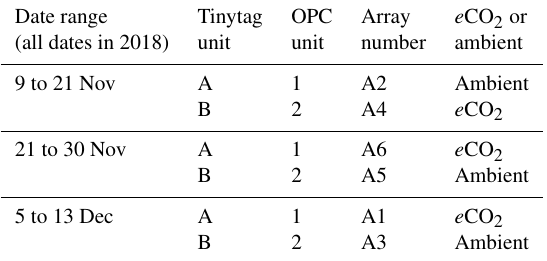
Table 1. Table listing the dates and locations of equipment installa- tion across the experimental duration at the BIFoR FACE site. Both optical particle counters (OPCs) and Tinytag relative humidity and temperature sensors were installed